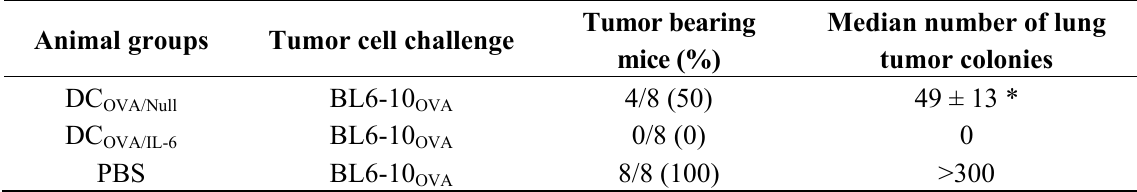
Table 1. DC induces therapeutic antitumor OVA/ IL6